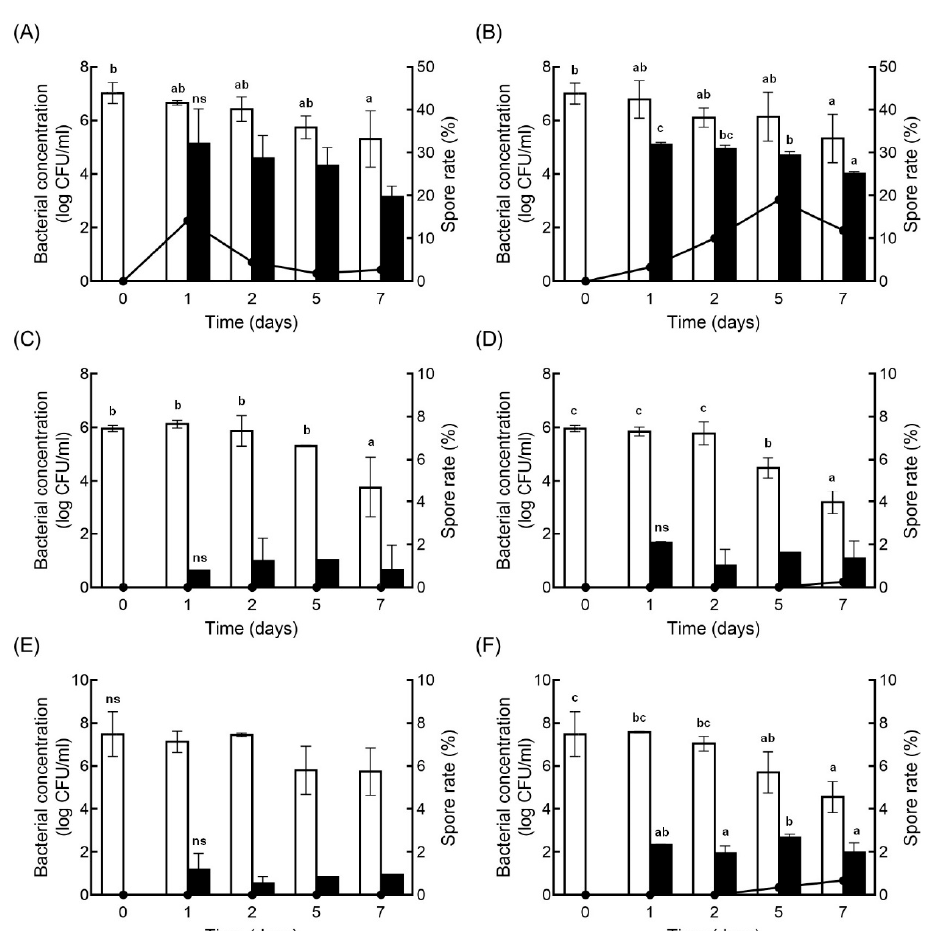
Figure 1. Vegetative cell counts and sporulation dynamics in biofilms. Vegetative cell ( □ ) and spore ( ▪ ) counts of C.